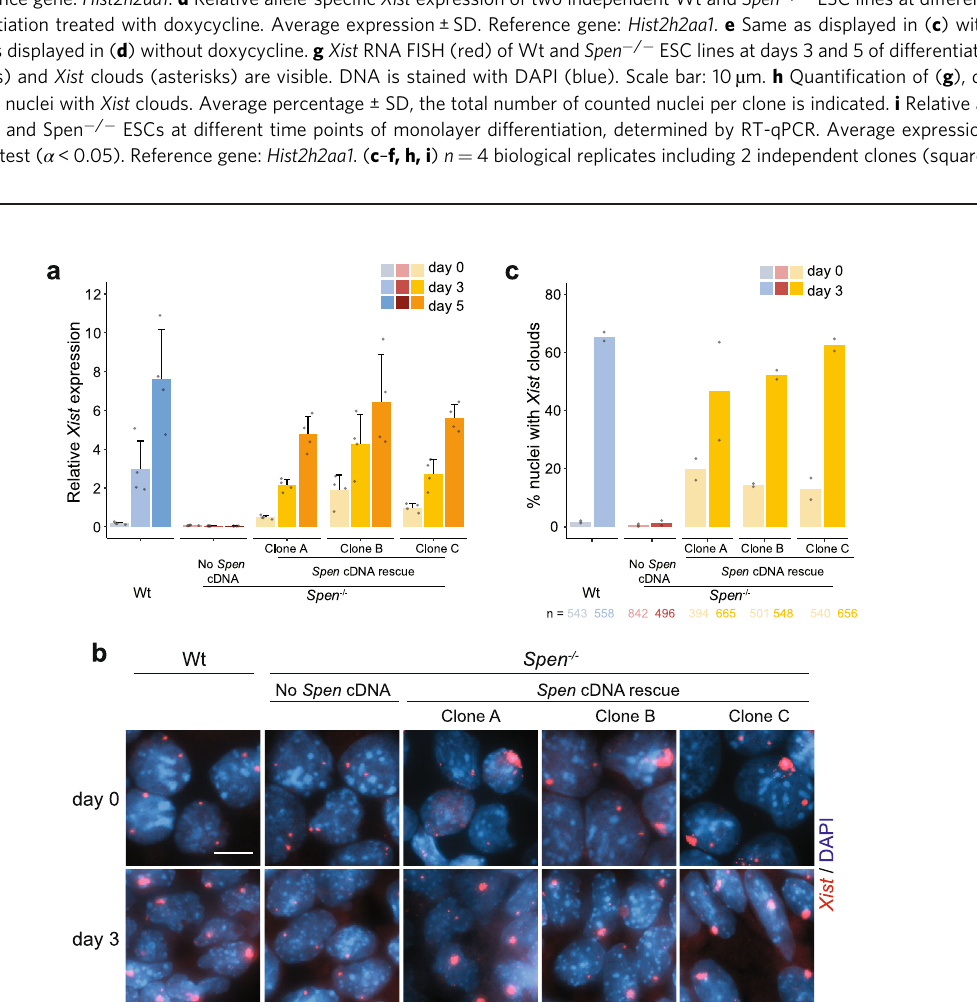
Fig. 2 Spen cDNA expression in Spen − / − ESCs rescues Xist expression. a Relative total Xist expression determined by RT-qPCR at days 0, 3, and 5 of monolayer differentiation of Wt, Spe n − / − and three independent rescue clones (Clone A, B and C). Average expression± SD, n = 4 biological replicates per condition. Reference gene: Hist2h2aa1 . b RNA FISH of Xist (red) at days 0 and 3 of monolayer differentiation of Wt, Spen − / − , and Spen rescue clones. DNA stained with DAPI (blue). Scale bar: 10 µ m. c Quanti fi cation of ( b ), showing the percentage of nuclei with Xist clouds in each condition. Average percentage, n = 2 biological replicates, the total number of counted nuclei is does not cause a differentiation phenotype. Interestingly, in undifferentiated Spen − / − (cDNA) ESC clones, Xist levels were higher than in Wt controls (Fig. 2a), and Xist RNA-FISH analysis revealed a signi fi cant percentage of Spen − / − (cDNA) undifferentiated ESCs having Xist clouds (Fig. 2b, c), probably due to higher SPEN abundance after overexpression in the undifferentiated state (Sup- plementary Fig. 3c).